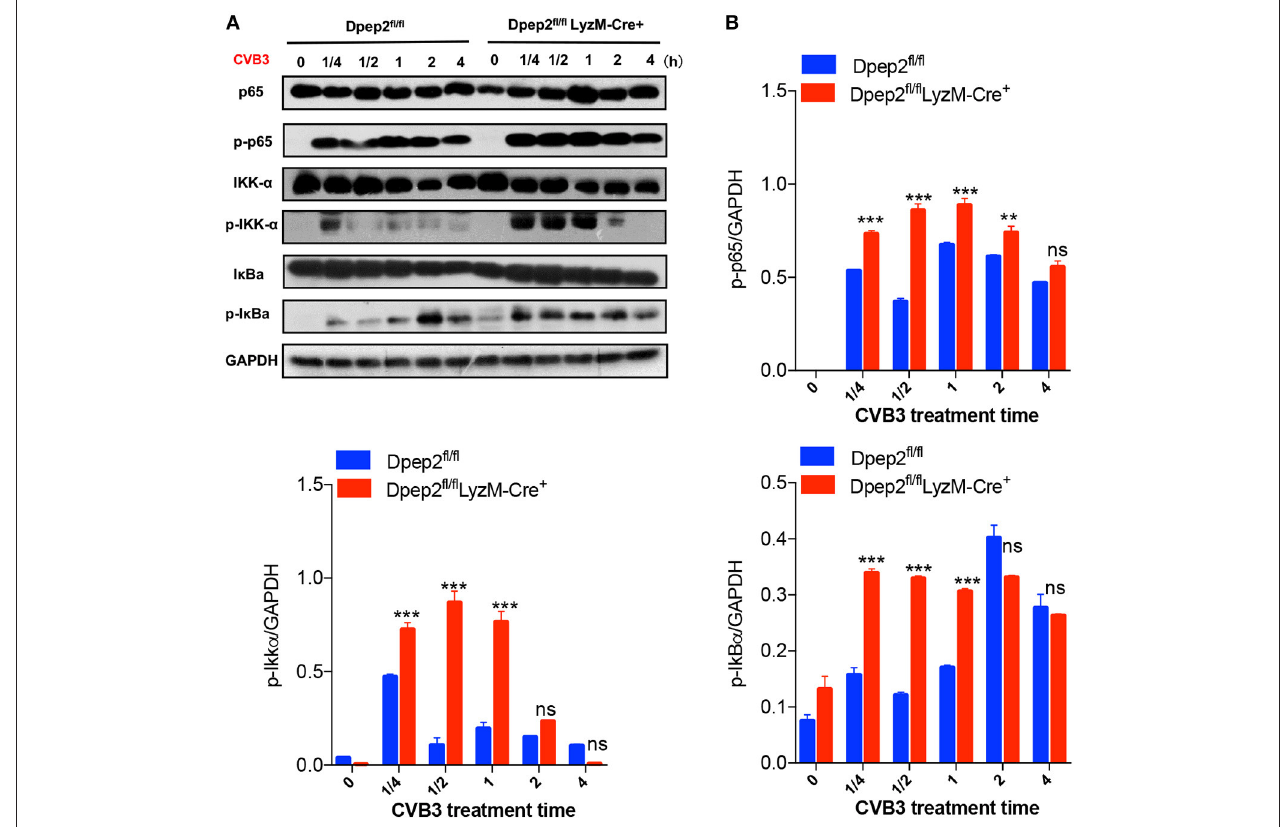
FIGURE 6 | Dpep2 repressed pro-inflammatory responses in macrophages by modulating NF- κ B signaling. (A) BMDMs derived from Dpep2 fl / fl LyzM-Cre + or Dpep2 fl / fl mice were treated with CVB3 (MOI = 10) for 15, 30, 60, 120, or 240min, and the levels of p65, IKK α , I κ B, p-p65, p-IKK α , and p-I κ B were analyzed by Western blot. (B) Band intensities were quantified by ImageJ software and normalized to GAPDH. Data were from one representative experiment among two independent experiments with similar results and were presented as the means ± S.E.M. ** p < 0.01; *** p < 0.001; ns, no